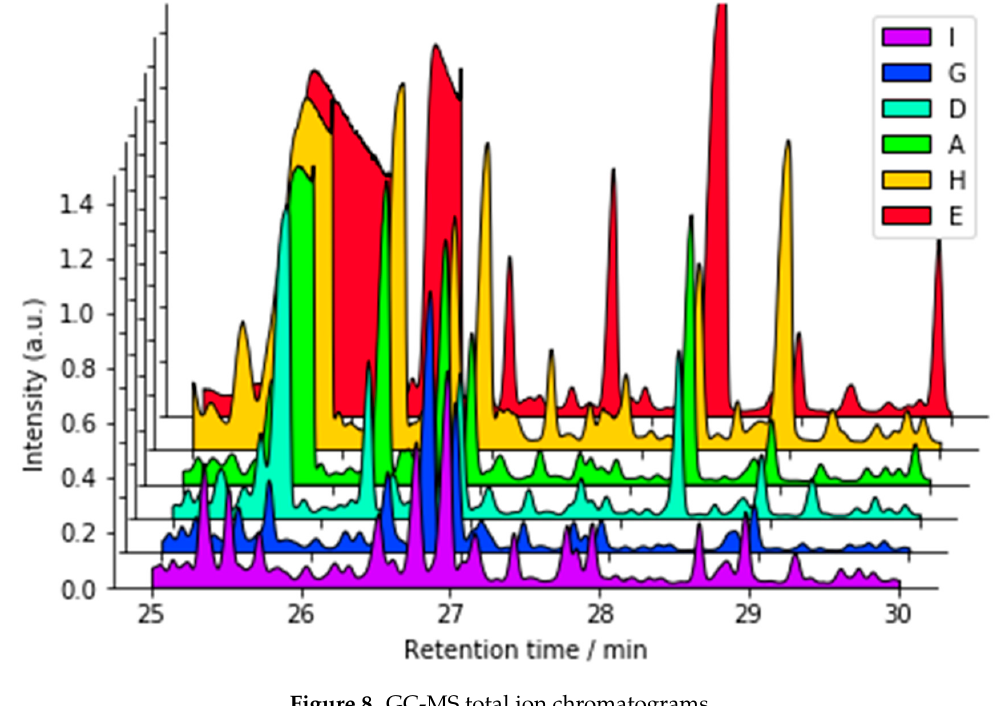
Figure 8. GC-MS total ion chromatograms.